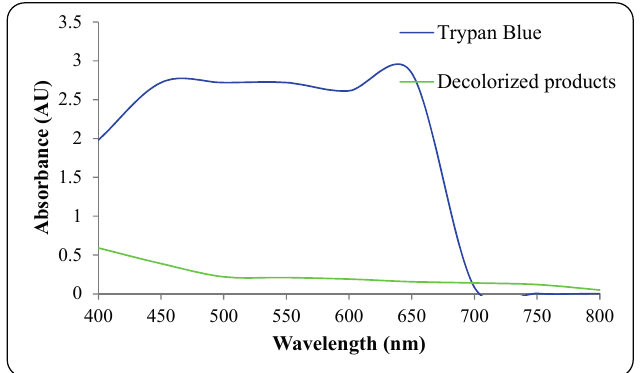
Figure 3. UV-visible overlay spectra of dye Trypan Blue and its ethyl acetate extracted decolorized products after 24 h treatment with microbial consortium.